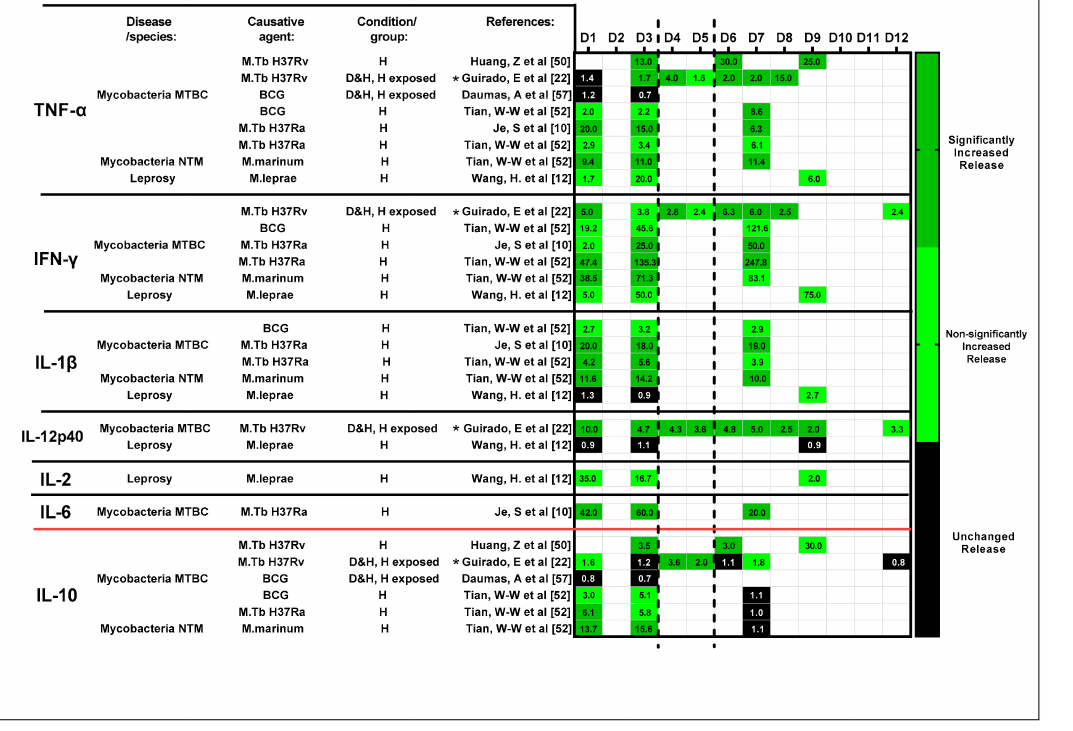
Figure 7. Change in the ratio of the cytokine secretion profile over time. The ratio of cytokine release of the exposed condition (pg/mL)/control condition (pg/mL) was tabulated based on the